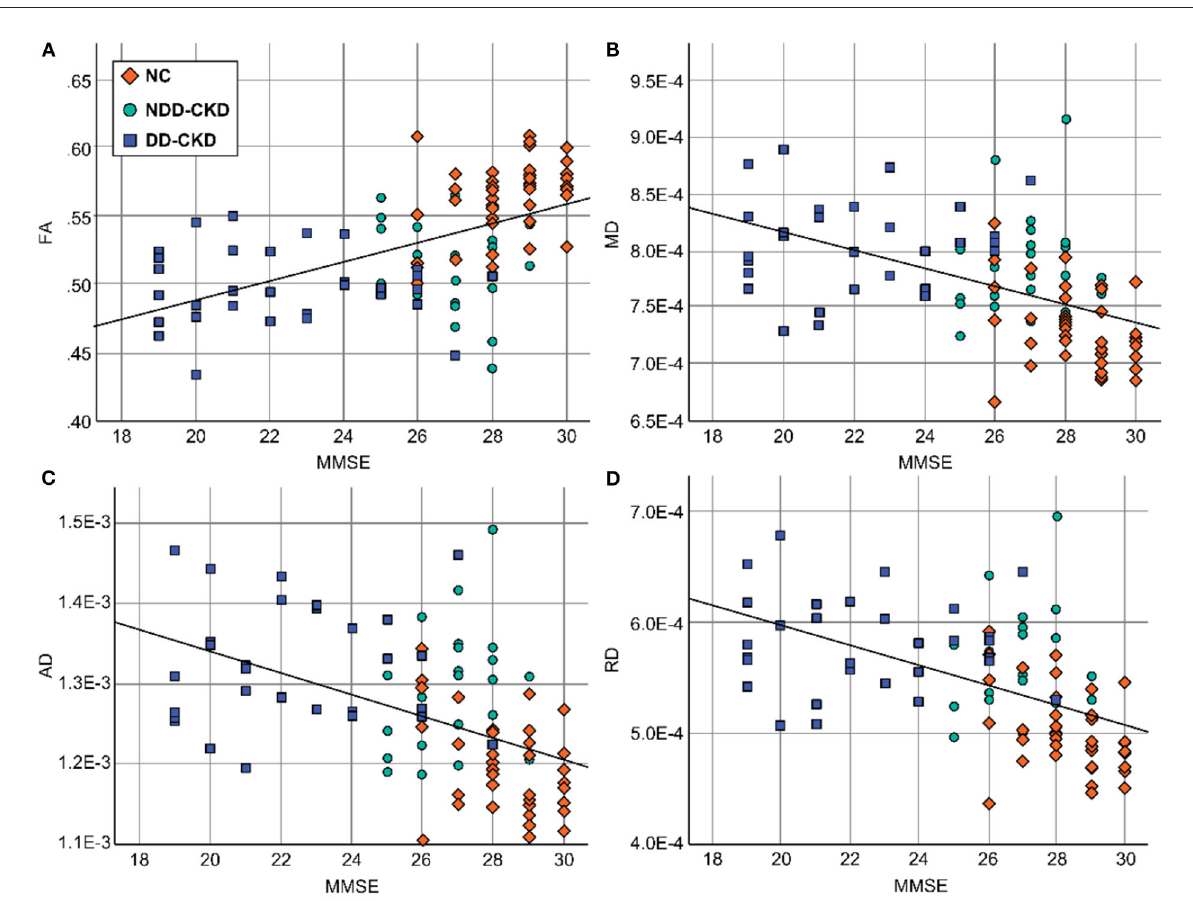
FIGURE4 Relationship between diffusion parameters and cognitive function in damaged brain white matter areas. (A) The FA values were positively correlated with the MMSE scores. (B) The MD values were negatively correlated with the MMSE scores. (C) The AD values were negatively correlated with the MMSE scores. (D) The RD values were negatively correlated with the MMSE scores. FA, fractional anisotropy; MD, mean diffusivity; AD, axial diffusivity; RD, radial diffusivity; MMSE, Simple Mental State